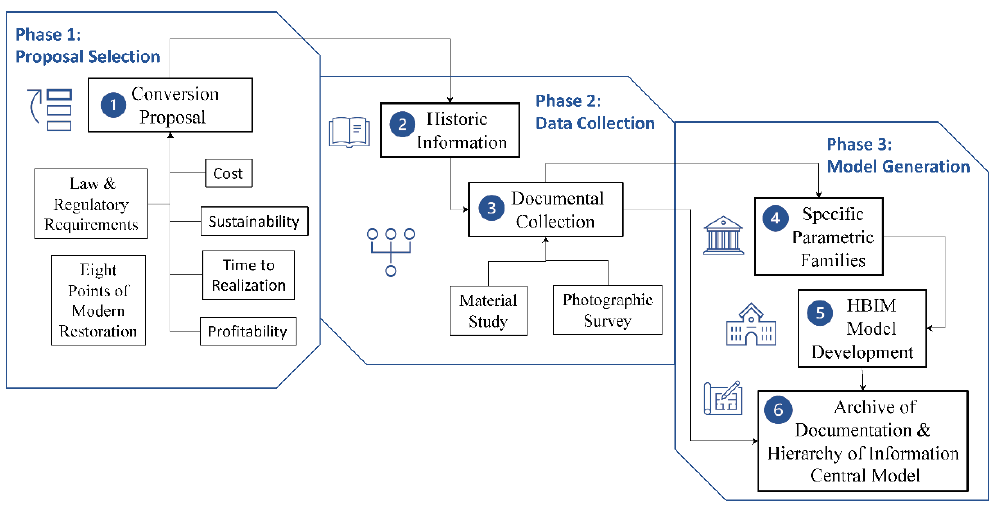
Figure 1. Development of specific parametric families for an HBIM library in the context of the conversion of a building of patrimonial value: general phases.